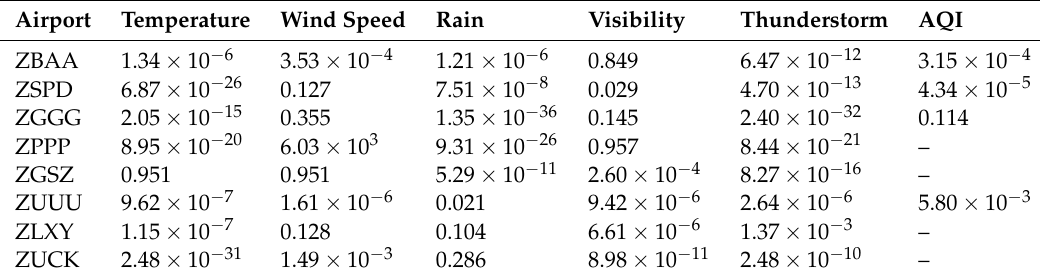
Table 3. Statistical relationships between weather, air quality and delays. Columns 2–7 report the p -values of χ 2 tests assessing the dependence between the average delay at each airport and the corresponding weather condition, as well as the air quality index (AQI). Airport Temperature Wind Speed Rain